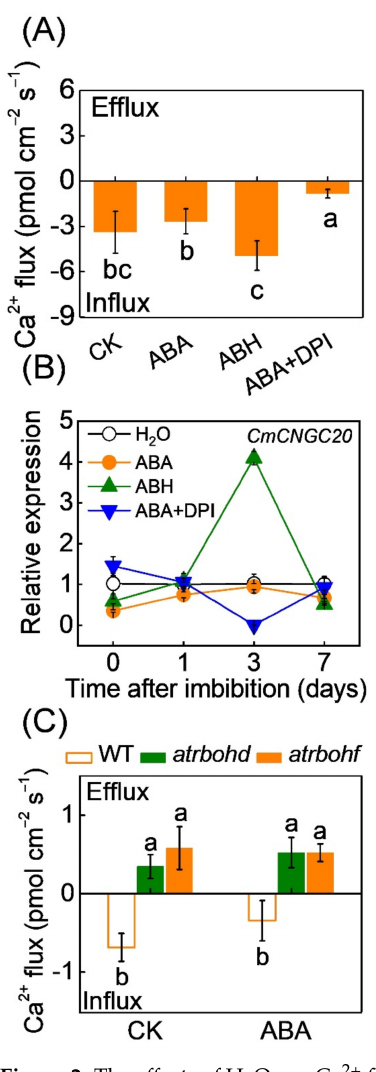
Figure 2. The effects of H 2 O 2 on Ca 2+ flux in seeds under ABA stress. ( A , B ) Ca 2+ flux and CmCNGC20 expression in melon seeds pre-treated with ABA, a combination of ABA and H 2 O 2 (ABH), and a combination of ABA and diphenyleneiodonium (DPI, an inhibitor of NADPH oxidases, which produces H 2 O 2 ). ( C ) Ca 2+ flux in seeds of wild-type (WT) Arabidopsis and atrbohd and atrbohf mutants under normal conditions and ABA stress. In ( A , C ), dry melon seeds or Arabidopsis were soaked in double distilled water or test solutions for 7 h and then were used to analyze the changes in Ca 2+ flux. In ( B ), melon seeds were treated as that in Figure 1. Data are means ± SD (3 replicates × 30 seeds). The different letters denote a significant difference ( p < 0.05) according to Tukey’s